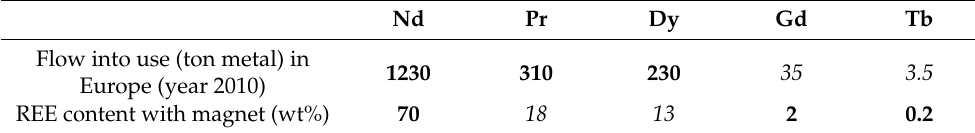
Table 3. REE mass flows and content in permanent magnets [8,17] (see text). Nd Pr Dy Gd